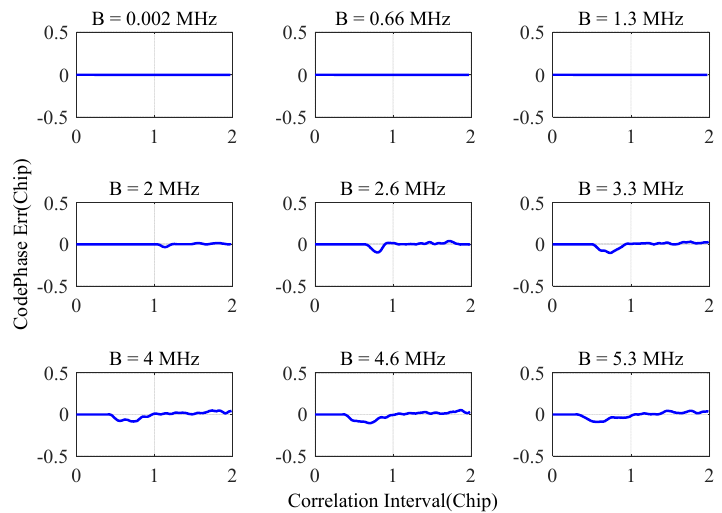
Figure 9. SCB distortions caused by narrowband interference suppression.